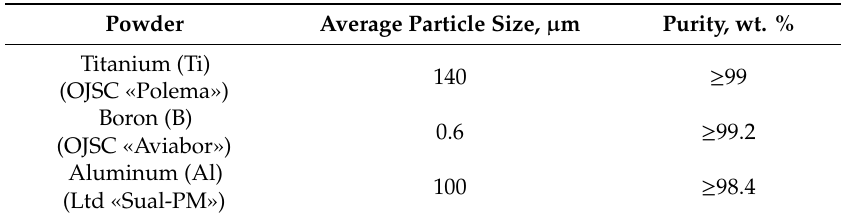
Table 1. Initial powders. Powder Average Particle Size, µ m Purity, wt.